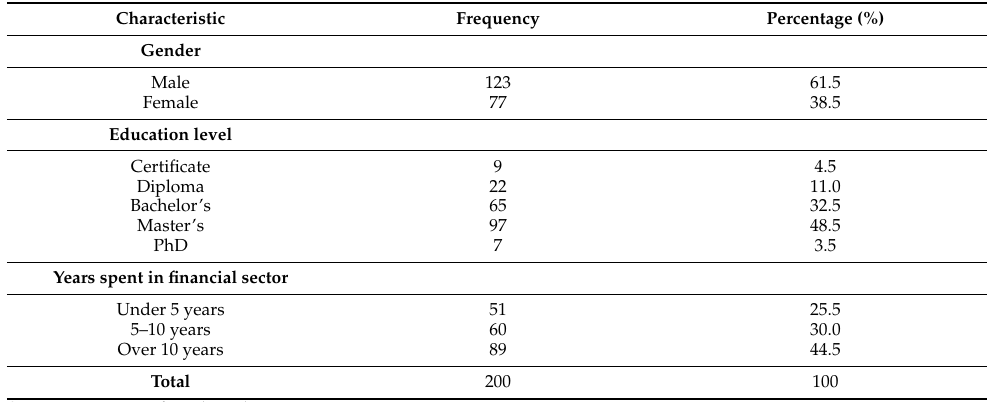
Table 2. Demographic characteristics of study